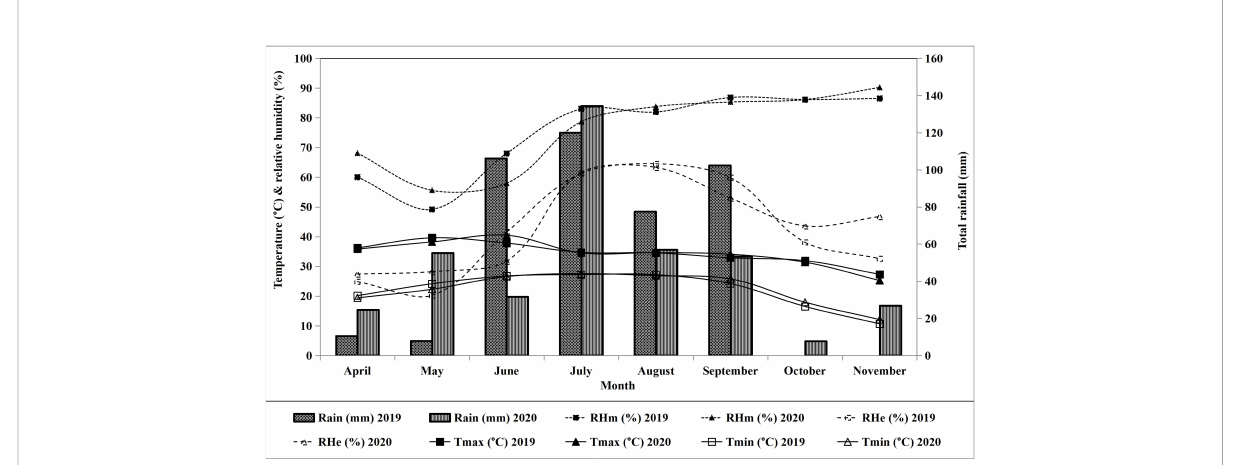
FIGURE 3 Weather data of the experimental site at Faridkot during crop growth periods 2019 and 2020. RHm, maximum relative humidity; RHe, minimum relative humidity; Tmax, maximum temperature; Tmin, minimum